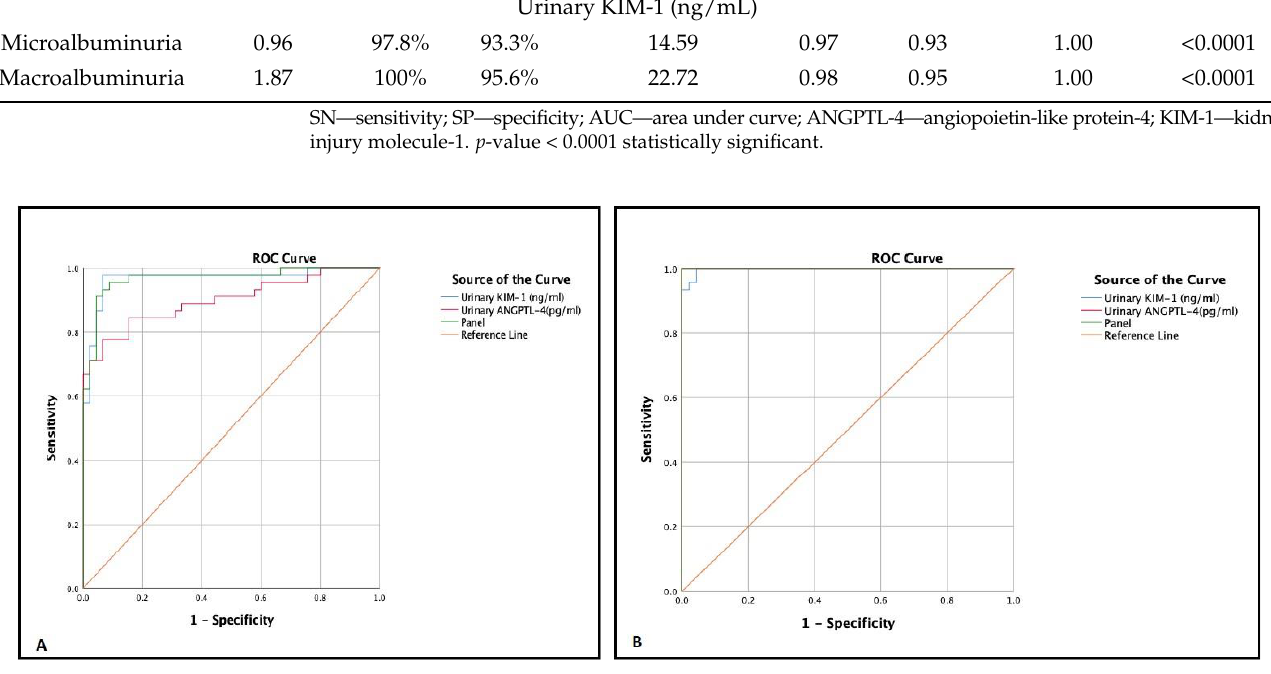
Figure 5. Receiver operating characteristic (ROC) analysis was performed for the prediction of diagnostic performance. ( A ) Type 2 diabetes mellitus patients with microalbuminuria [KIM-1: AUC 0.967; ANGPTL4: AUC 0.899; Panel: AUC 0.967, p < 0.0001]. ( B ) Type 2 diabetes mellitus patients with macroalbuminuria [KIM-1: AUC 0.998; ANGPTL4: AUC 1; Panel: AUC 1, p < 0.0001].